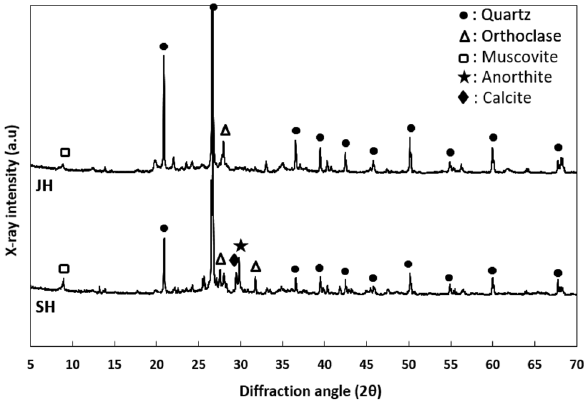
Fig. 3 XRD patterns of dredged sea soil.